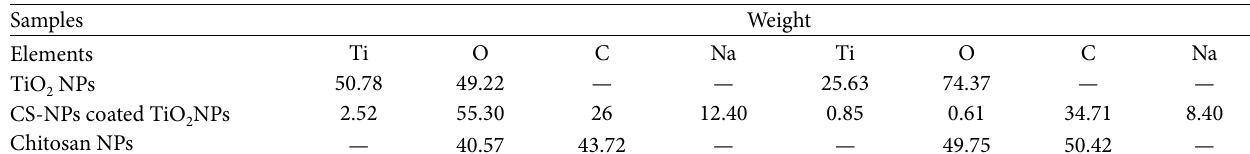
Table 1: EDX of synthesized nanomaterials.